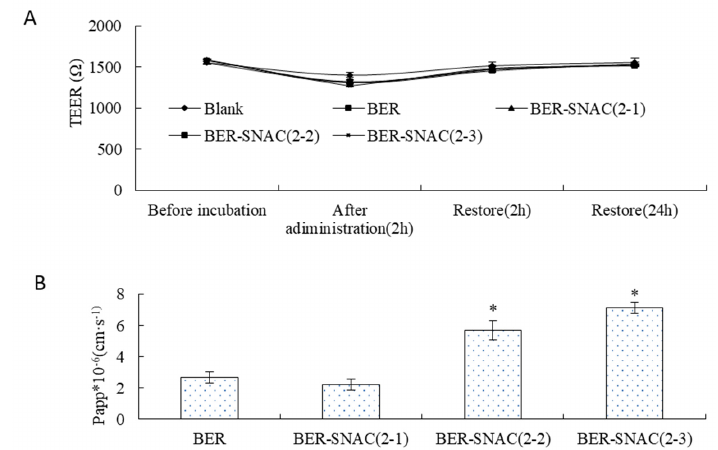
Figure 2. Transport across the Caco-2 cell monolayer. ( A ) Transepithelial electrical resistance (TEER) of Caco-2 cell monolayer before and after treatment with berberine hydrochloride (BER) and BER mixed with sodium N -[8-(2-hydroxybenzoyl)amino]caprylate (SNAC). ( B ) Papp of BER transport across Caco-2 cell monolayer treatment with BER and BER mixed with SNAC. Data were represented as mean ± SD ( n = 3, each group). * p < 0.05 vs. BER group.